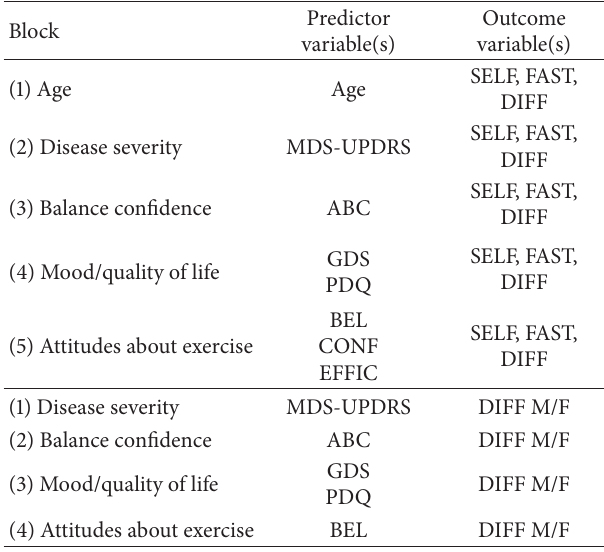
Table 1: Regression model